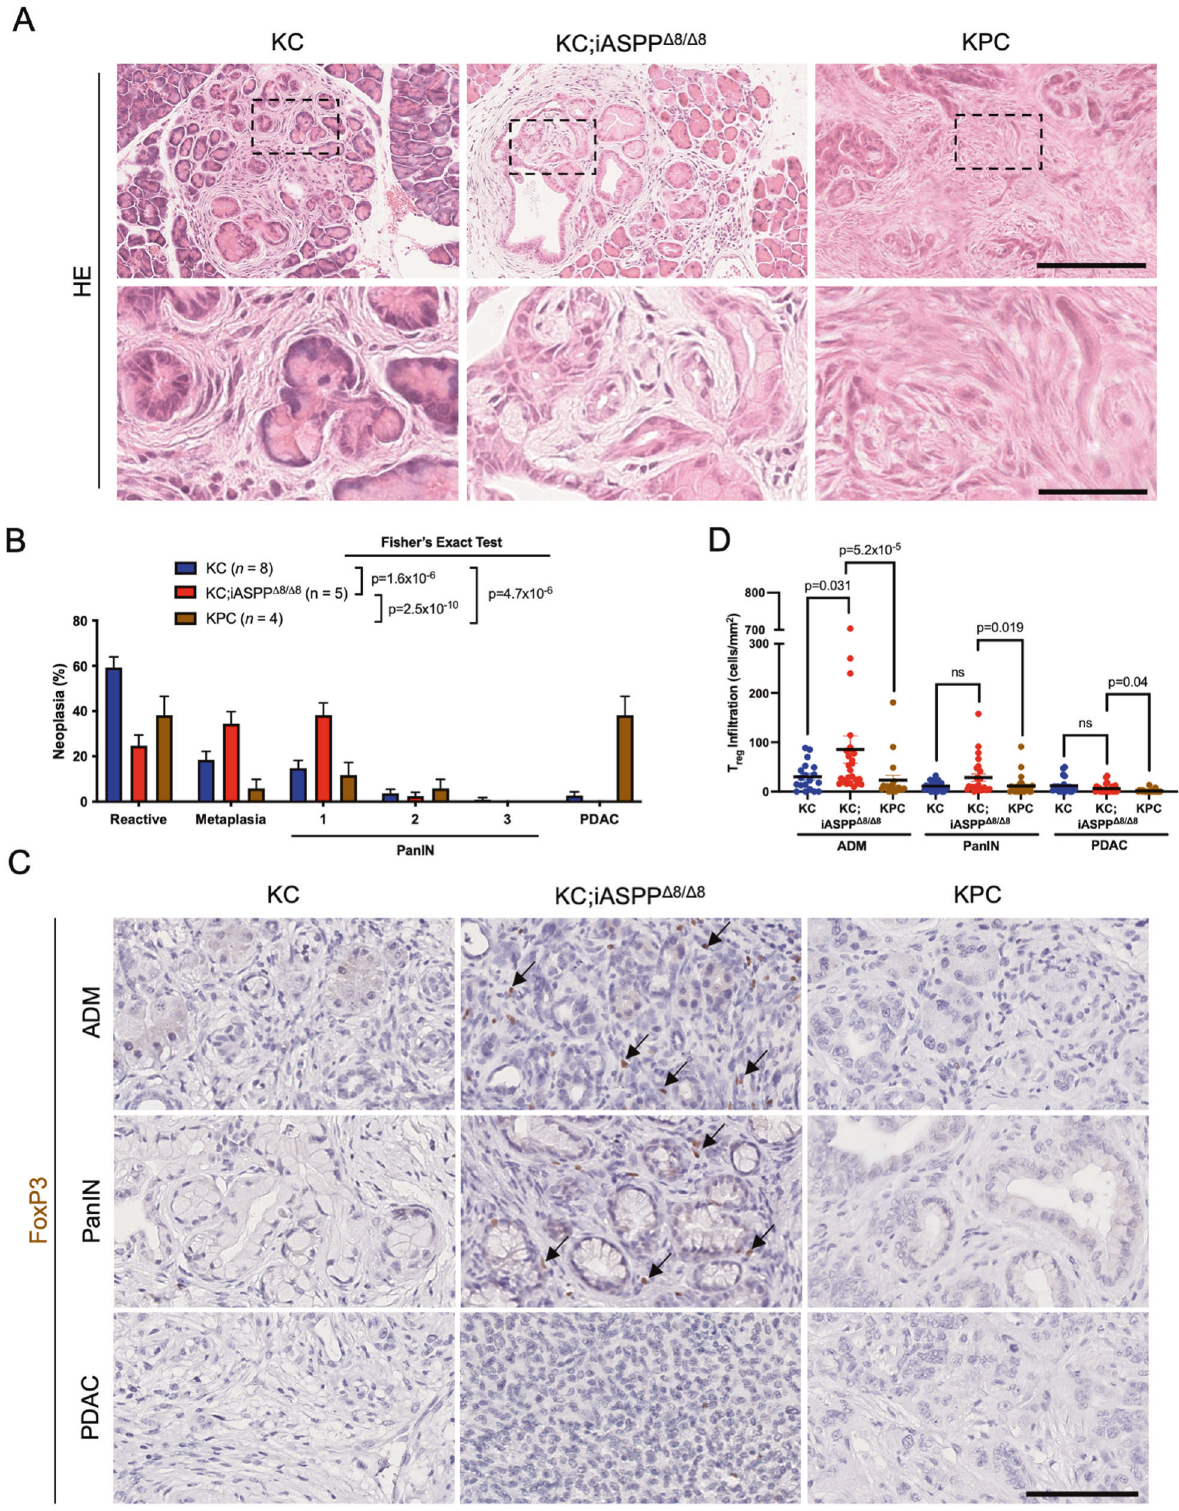
Fig. 3 Pancreatic Tumors Lacking iASPP Have Increased Treg In fi ltration. A Representative HE stains of pancreas isolated from 25-week-old Kras LSL − G12D/ + ;Pdx1-Cre (KC, n = 5), and Kras LSL − G12D/ + ;iASPP fl / fl ;Pdx1-Cre (KC;iASPP Δ 8/ Δ 8 , n = 6), and Kras LSL − G12D/ + ;Trp53 LSL − R172H/ + ;Pdx1-Cre (KPC, n = 5) mice. Higher magni fi cation shown below. Scale, 200 μ m (top) and 50 μ m (bottom). B Proportion of reactive neoplasia, metaplasia, PanIN, versus PDAC of all pancreatic lesions in KC ( n = 8, blue), KC;iASPP Δ 8/ Δ 8 ( n = 5, red), or KPC ( n = 4, brown) mice. Data are sample proportion ±standard error of the sample proportion; Fisher ’ s exact test, p < 0.05 indicated on graph. C FoxP3 stains of pancreata isolated from KC ( n = 5), KC;iASPP Δ 8/ Δ 8 ( n = 5), or KPC ( n = 5) mice. Arrows indicate FoxP3 + cells. Scale, 100 μ m. ADM acinar to ductal metaplasia, PanIN pancreatic intraepithelial neoplasia, PDAC pancreatic ductal adenocarcinoma. D Column scatter plot shows quanti fi cation of pancreatic neoplasia-in fi ltrating FoxP3 + T reg cells per area.